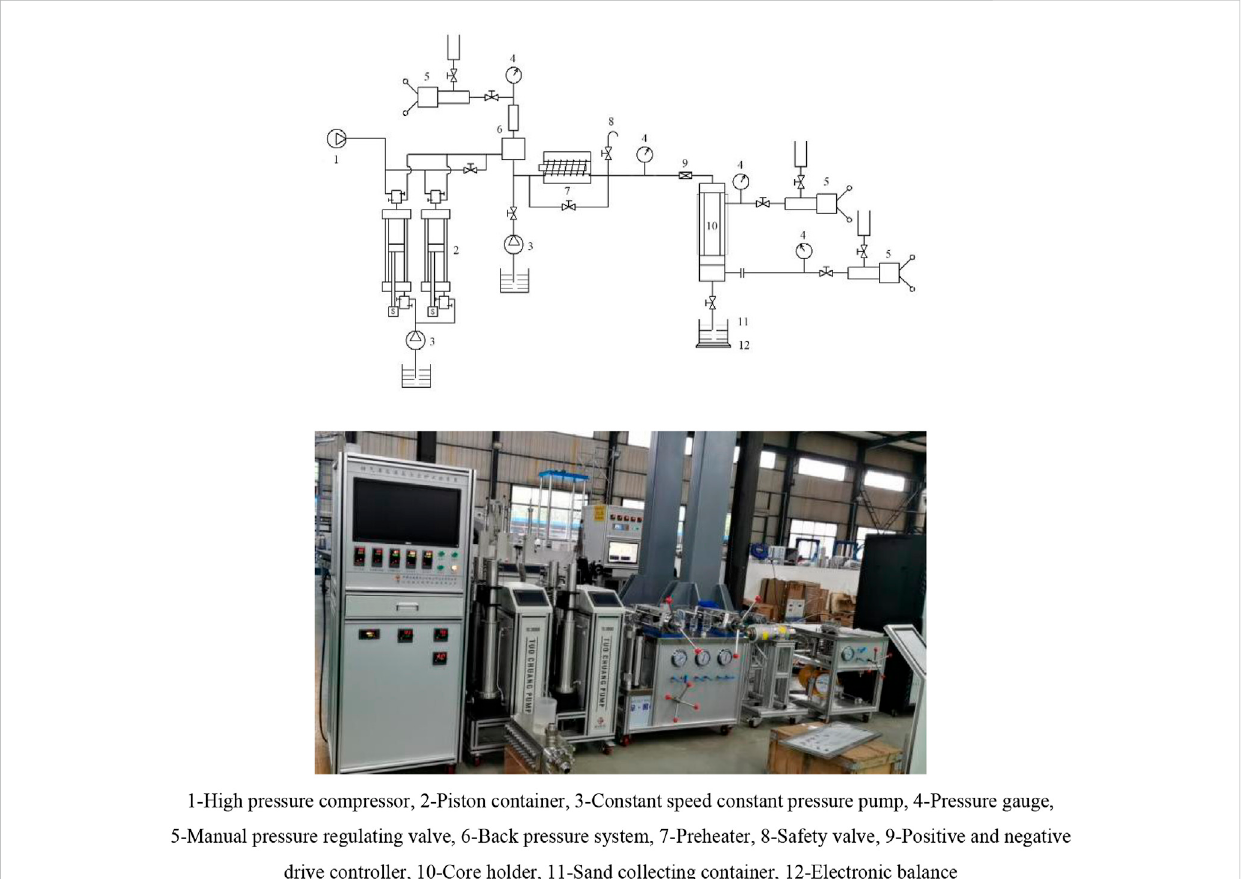
FIGURE 1 Diagram of sand production simulation device for gas storage (Ma et al., 2022).